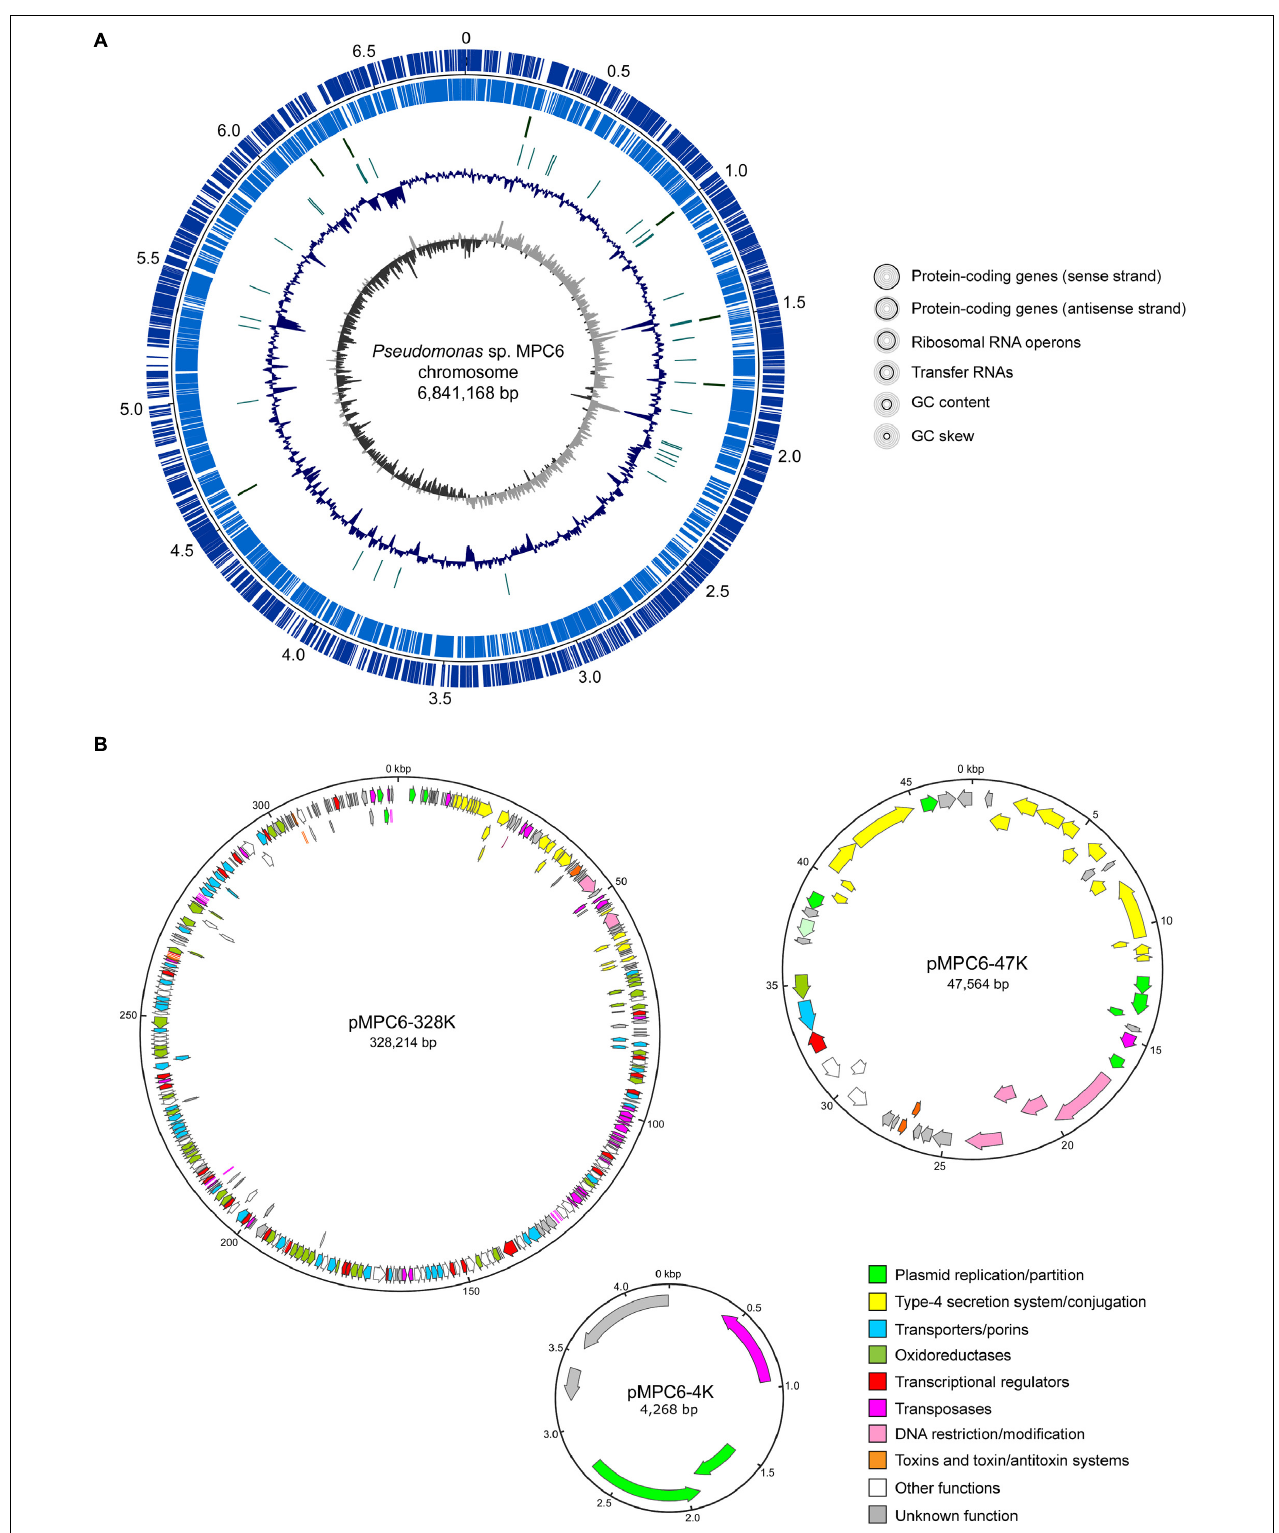
FIGURE 1 | Circular maps showing the main features of the Pseudomonas sp. MPC6 chromosome and the three plasmids that compose its genome. (A) Chromosome map showing the protein coding genes in both strands, the genes coding for ribosomal and transfer RNAs, the GC content and the GC skew. (B) Map of the plasmids pMPC6-328K, pMPC6-47K, and pMPC6-4K. The genes identified inside each plasmid were colored according to its predicted